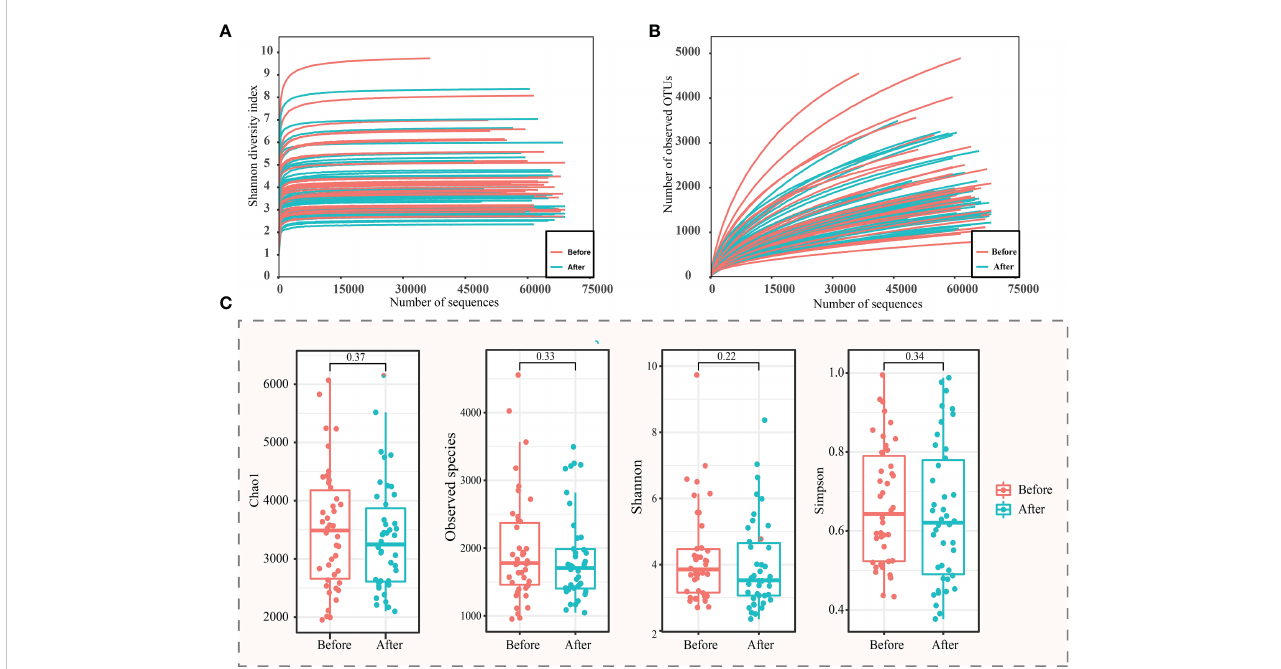
FIGURE 2 a -diversity analysis of vaginal microbiota before and after the use of the postbiotic gel. Rarefaction curves of (A) Shannon diversity and (B) observed operational taxonomic units (OTUs). (C) Box plots of alpha diversity (chao1, observed species, Shannon and Simpson diversity indexes) before and after using postbiotic